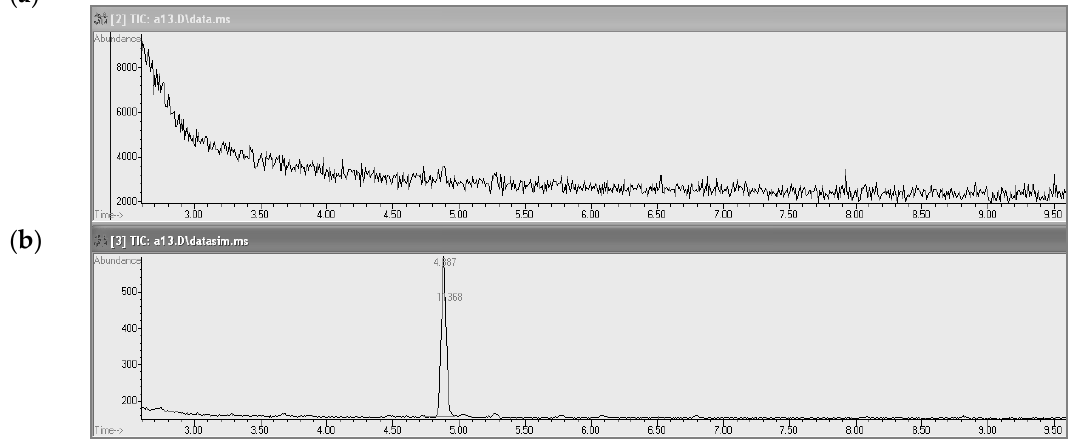
Figure 1. Chromatogram of the PS standard solution in acetonitrile at 0.25 µ g / mL (1 / 10 MAC value) using GC-MS. HP-5MS column (30 m x 0.25 mm; 0.25 µ m), programmable temperature, ( a ) SCAN no peak, ( b ) SIM (solvent cut-o ff 2.5 min): propane-1,3-sultone (t R = 4.887 min).